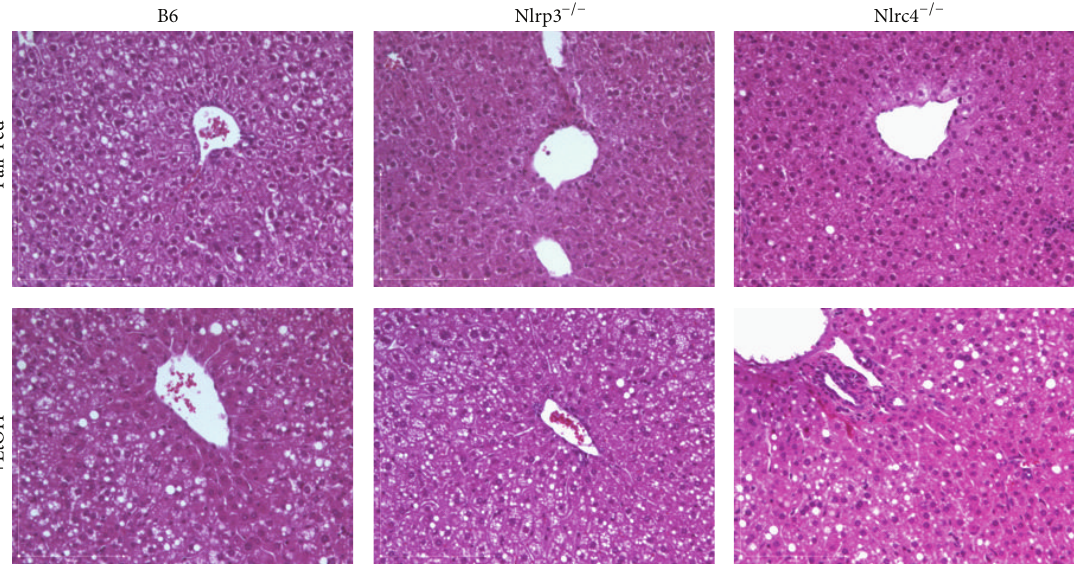
Figure 1: Analysis of steatosis with alcohol feeding. Hematoxylin and Eosin (H&E) staining of livers from C57BL/6J (B6), Nlrp 3 −/− , and Nlrc 4 −/− mice fed pair-fed control diets (Pair-Fed) or ethanol-containing diets (+EtOH). Figures are representative of 6 mice per group. Original magnification, ×